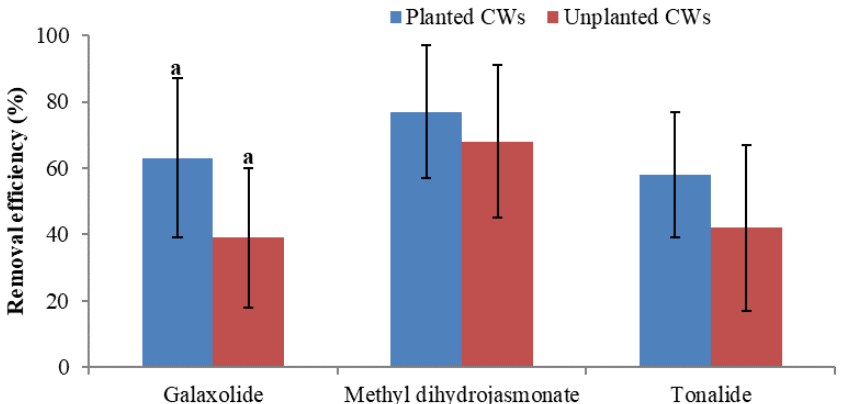
Figure 3. The removal efficiency (mean and standard deviation) of PCPs in planted and unplanted CWs. Note: Galaxolide: “a” shows the significant difference in the removal efficiency in planted and unplanted CWs at α = 0.05 ( p < 0.05). The number of observations for studied PCPs in planted and unplanted CWs is given in Table S8 (Supplementary Materials).